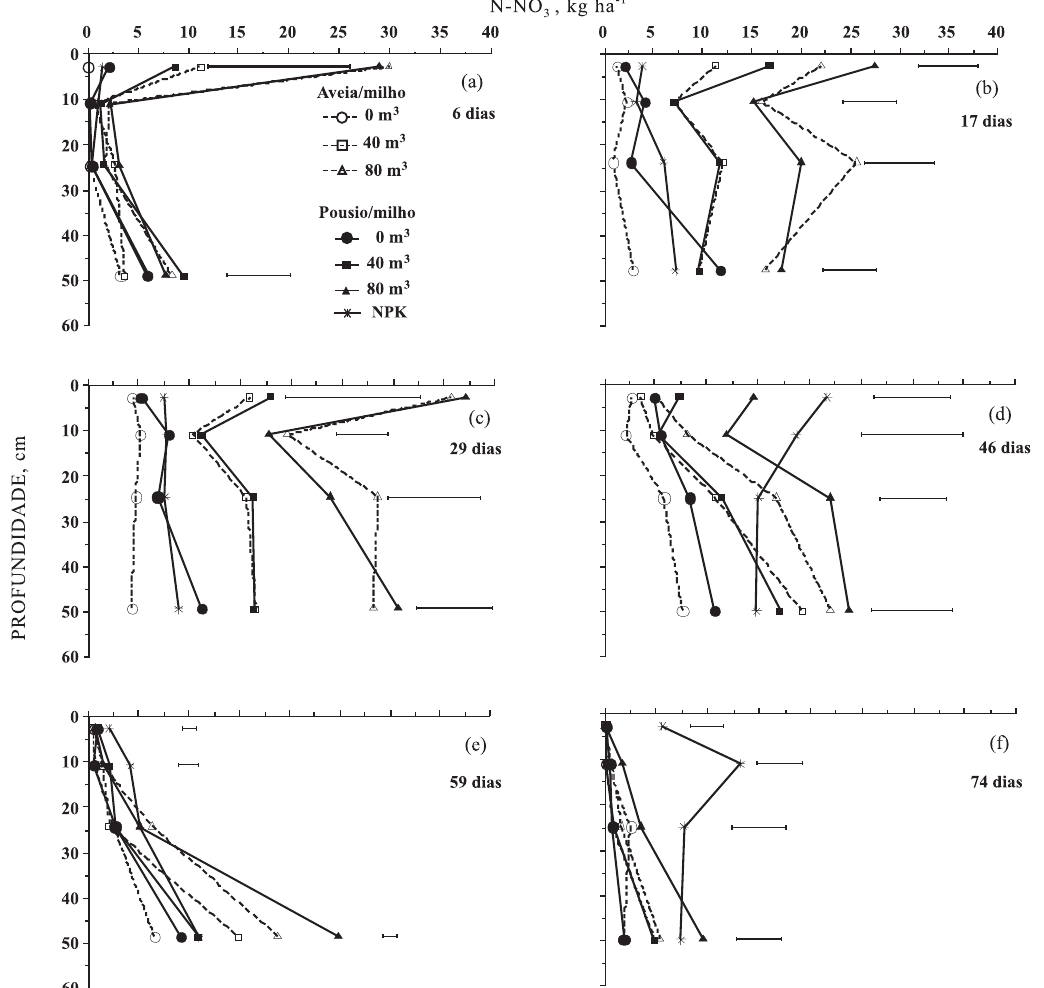
Figura 2. Quantidades de N-NO 3- na camada de 0–60 cm do solo durante o cultivo de milho, aos 6, 17, 29, 46, 59 e 74 dias após a aplicação dos dejetos (0, 40 e 80 m 3 ha -1 ), nos sistemas aveia/milho e pousio/milho